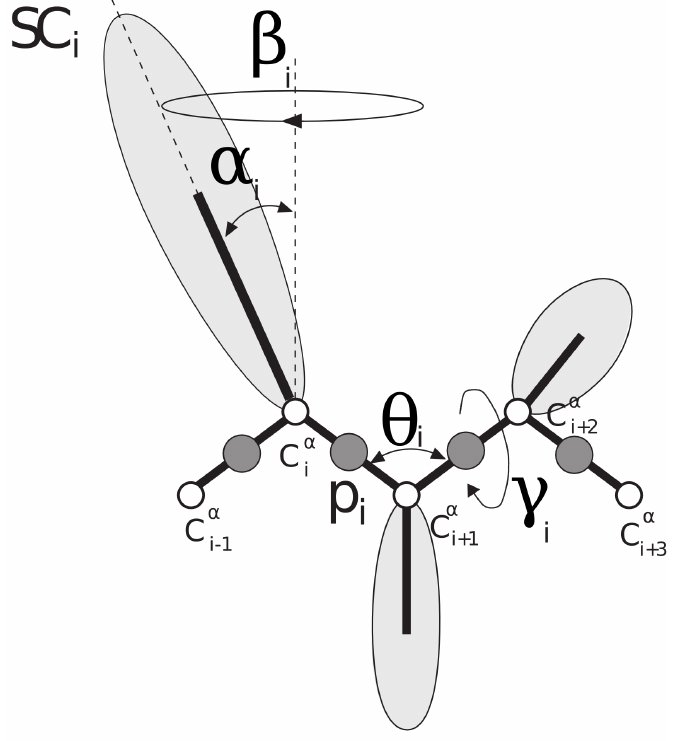
Figure 1. Schematic representation of the UNited RESidue (UNRES) model of the polypeptide chain. There are two interaction sites per residue: united side-chain (SC) and united peptide group (p) are represented by light-gray ellipses and dark-gray circles, respectively. C α atoms (white circles) and the angles β , α , Θ , and γ define the positions of the backbone and side